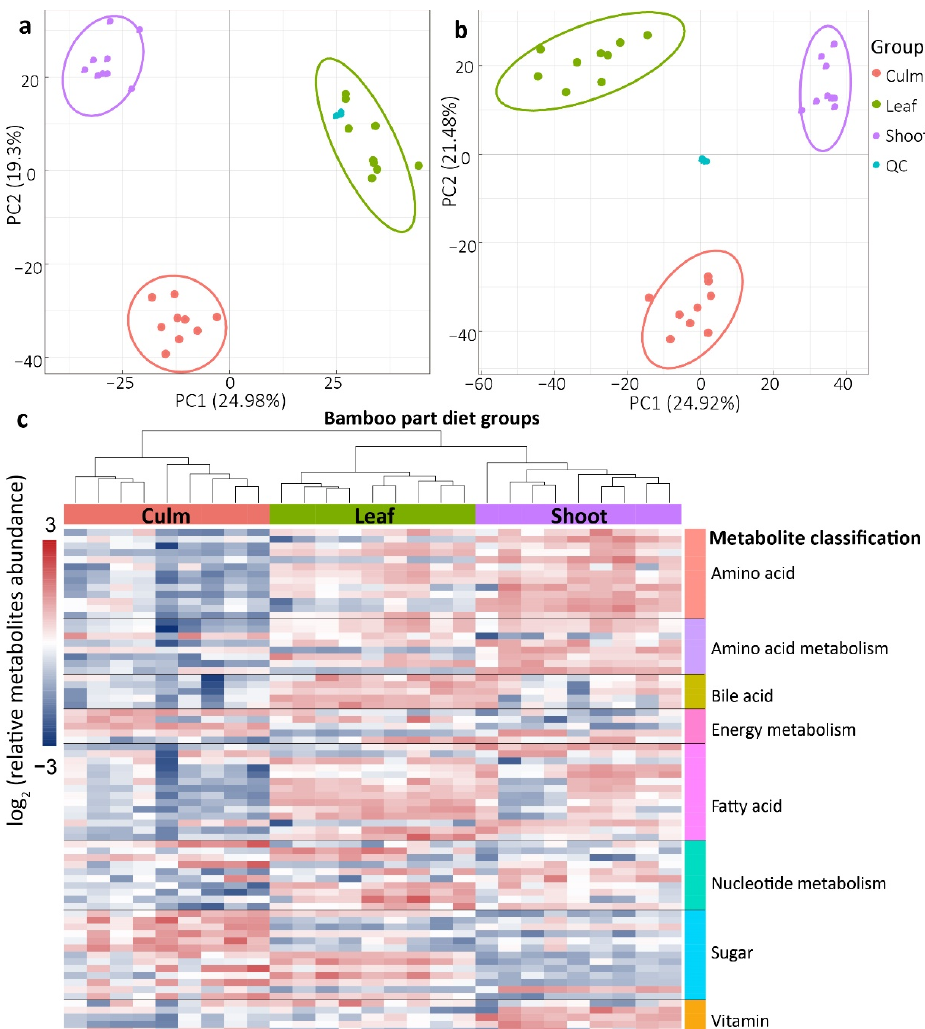
Figure 1. Detected differences in the bamboo culm, leaf, and shoot diet in the overall fecal metabolite profiles of giant pandas by using the non-targeted metabolomics method. The fecal metabolites were separated and clustered into the three bamboo groups in ( a ) positive and ( b ) negative ion pattern PLS-DA score diagram. ( c ) Heatmaps showed that different nutrient intakes caused changes in fecal metabolites. The color indicates the homogenized data, red cells indicate a higher abundance of metabolites, and blue cells indicate a lower abundance. Measured metabolites that could be assigned to a category are